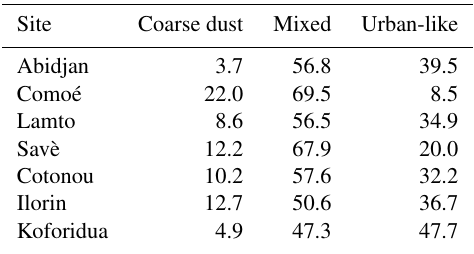
Table 3. Percentage of daily observations in the aerosol categories at each